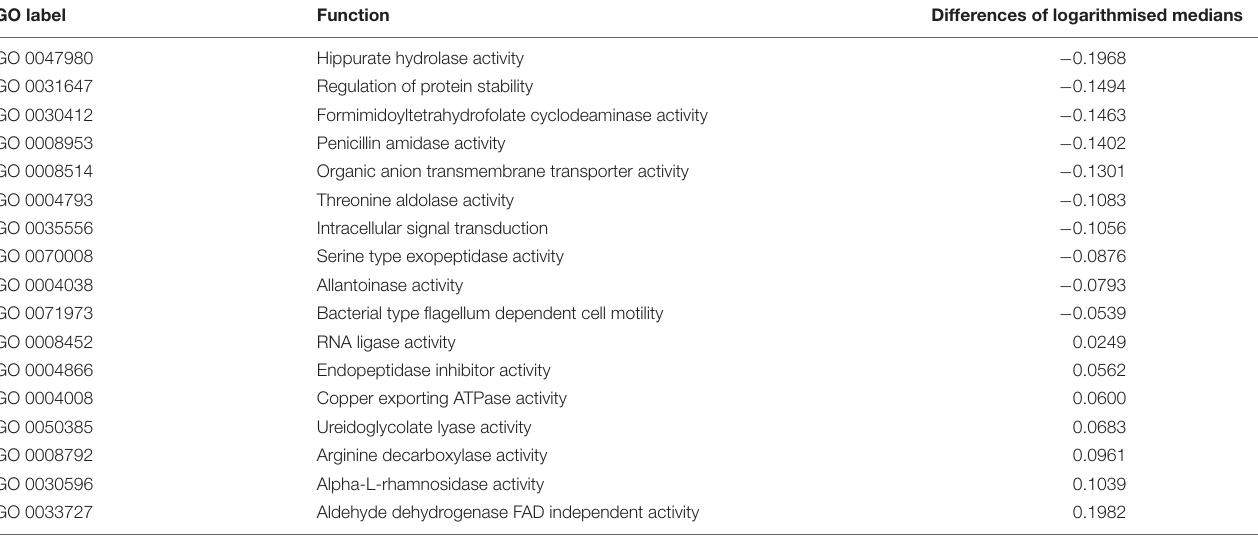
TABLE 3 | The differences of logarithmised medians of the features included in the GO (Gene Ontology) model. GO label